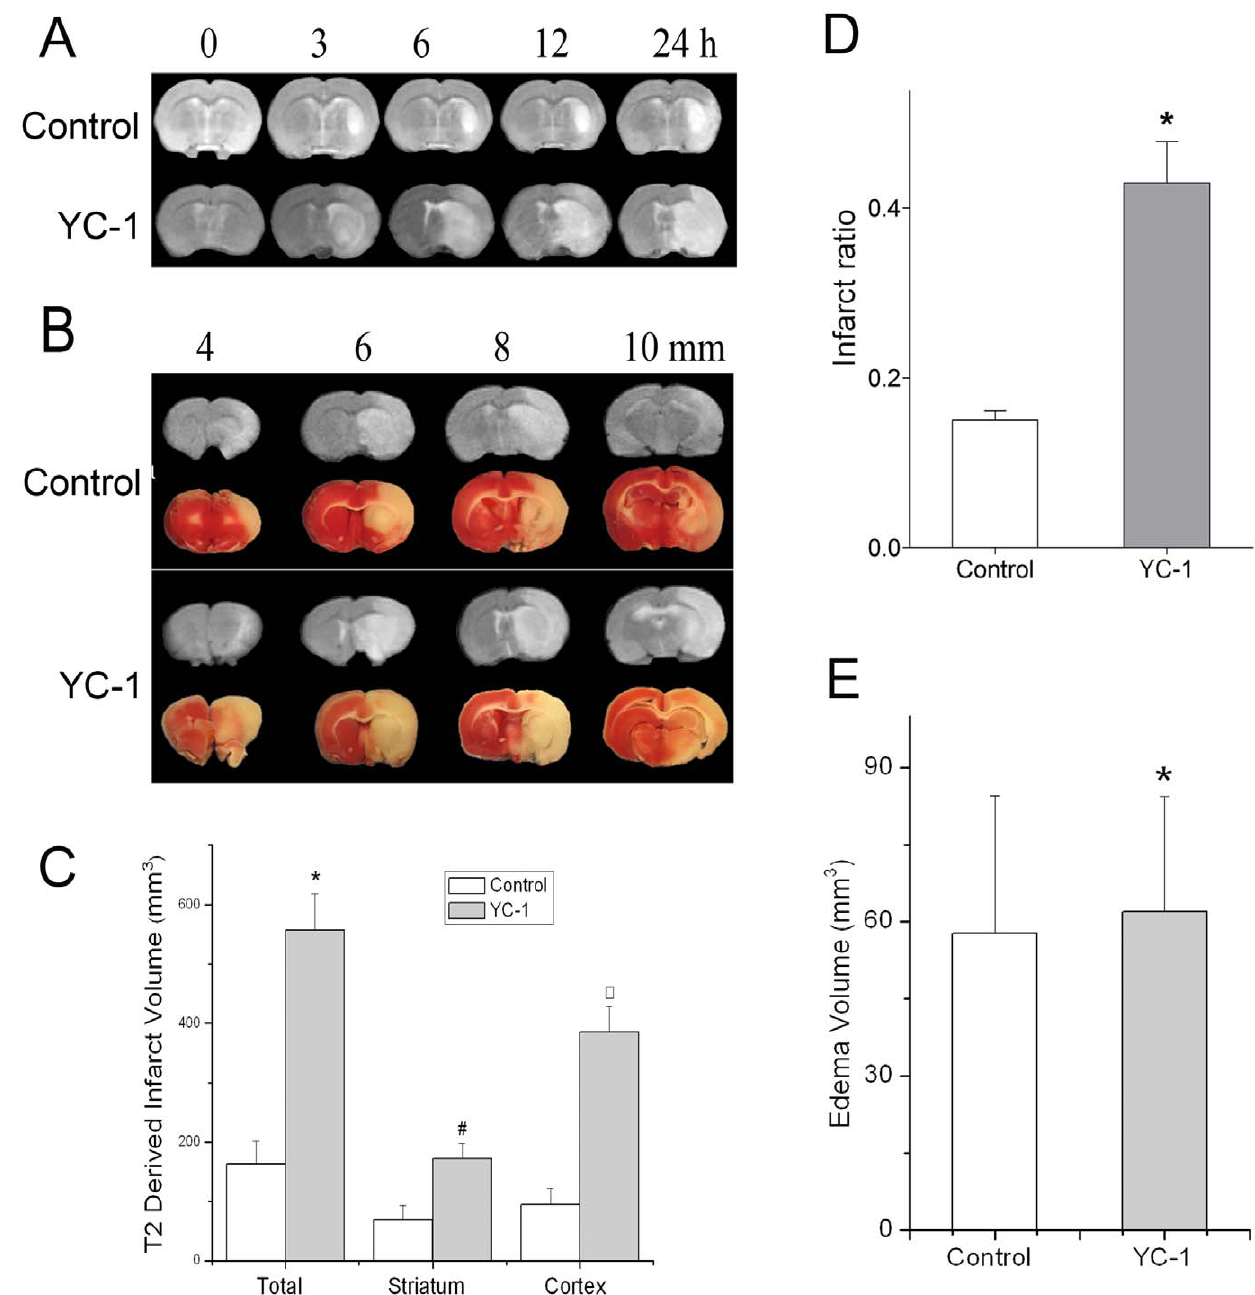
Figure 3. Effect of YC-1 on brain tissue damage of MCAO rats. Brian damage was estimated by MRI and TTC staining after rats were subjected to 90 min ischemia and 24 hr reperfusion. Animals received YC-1 (2 mg/kg, i.v.) at 24 h and 30 min prior to the onset of ischemia. ( A ) Representative MRI images showing time-dependent progression of infarct volumes. T2 weighted MRI images were collected at 0, 3, 6, 12, and 24 hr after MCAO with white area representing infarct area. ( B ) Representative TTC staining (lower panel) and T2 (upper panel) images of brain sections of a MCAO rat. The brain was sectioned from the 4 mm position from the frontal pole and continued in 2-mm interval to 10 mm. ( C ) Quantification of infarct volume with T2-weighted MRI images of rat brain (n=12 (control), 9 (YC-1)). ( D ) Quantification of brain damage estimated by TTC stained sections (n=12 (control), 9 (YC-1)). ( E ) Quantification of brain edema volume estimated by TTC stained sections (n=12 (control), 9 (YC-1)).Values are means 6 SEM. * p , 0.05 vs. control. # p , 0.05 vs. control striatum. % P , 0.05 vs. control